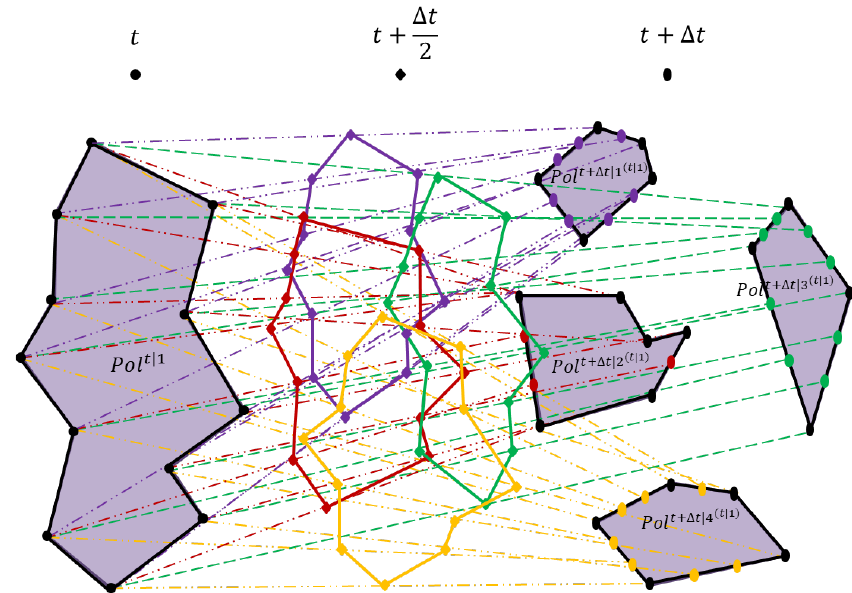
Figure 6. Illustration of interpolation without decomposition of the current polygon. On a radar screen, only the envelope curve is presented. Corresponding mapping is visualized in different colors.